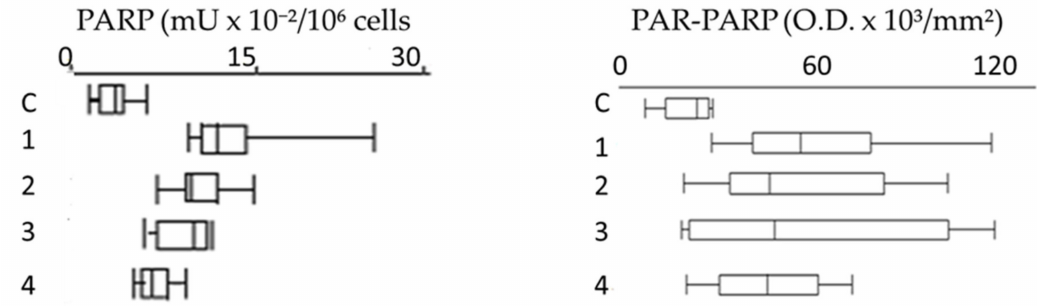
Figure 8. Box plots of PARP activity and PAR-PARP levels in different groups. C, Controls; 1, Group 1E; 2, Group 2E; 3, Group 3E; 4, indirectly